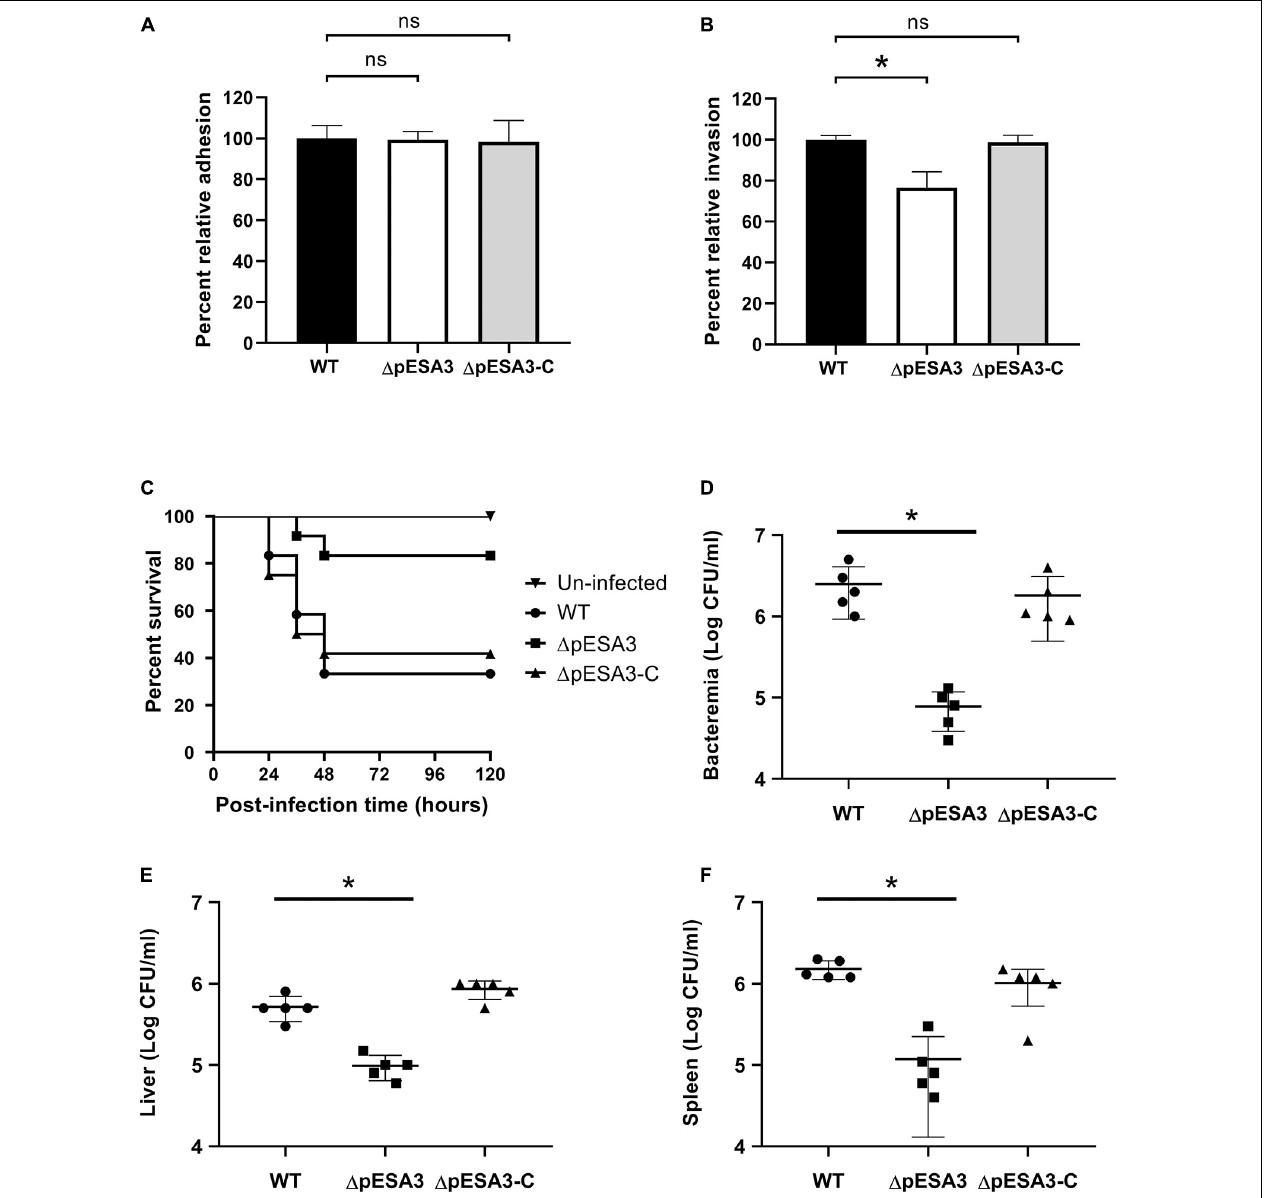
FIGURE 3 | The endogenous plasmid pESA3 contributes to the virulence of Cronobacter sakazakii BAA-894. Adhesion (A) and invasion (B) of Caco-2 cells by WT, (cid:49) pESA3 and (cid:49) pESA3 complementation ( (cid:49) pESA3 - C) C. sakazakii strains ( n = 3). (C) Survival curves of rat pups 120 h after oral infection. (D–F) Colony-forming unit (CFU) counts at 24 h postinfection from the blood, liver, and spleen of orally infected rats. Blood samples were collected from facial veins, liver and spleen, homogenized and serially diluted. The diluents were plated on LB agar for colony enumeration. The data are presented as the means and standard deviation of five biological repeats (Student’s t -test; ns, no significant difference, * P <